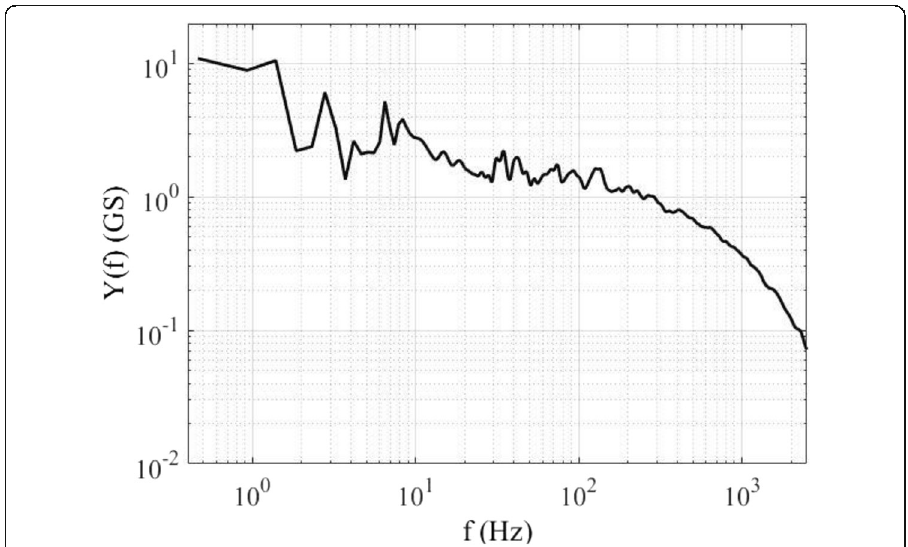
Fig. 14 Ensemble-averaged grayscale spectral energy distribution for locations near the shock wave for data acquired on 05 April